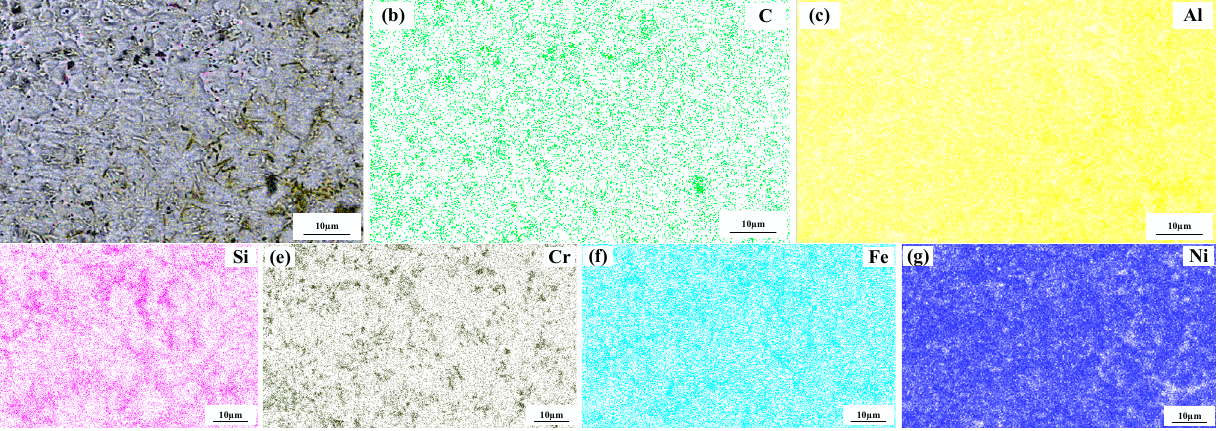
Figure 6. Composition analyses of surface scanning for specimen 3 (1% graphene content): ( a ) SEM image; ( b ) Al; ( c ) Ni.